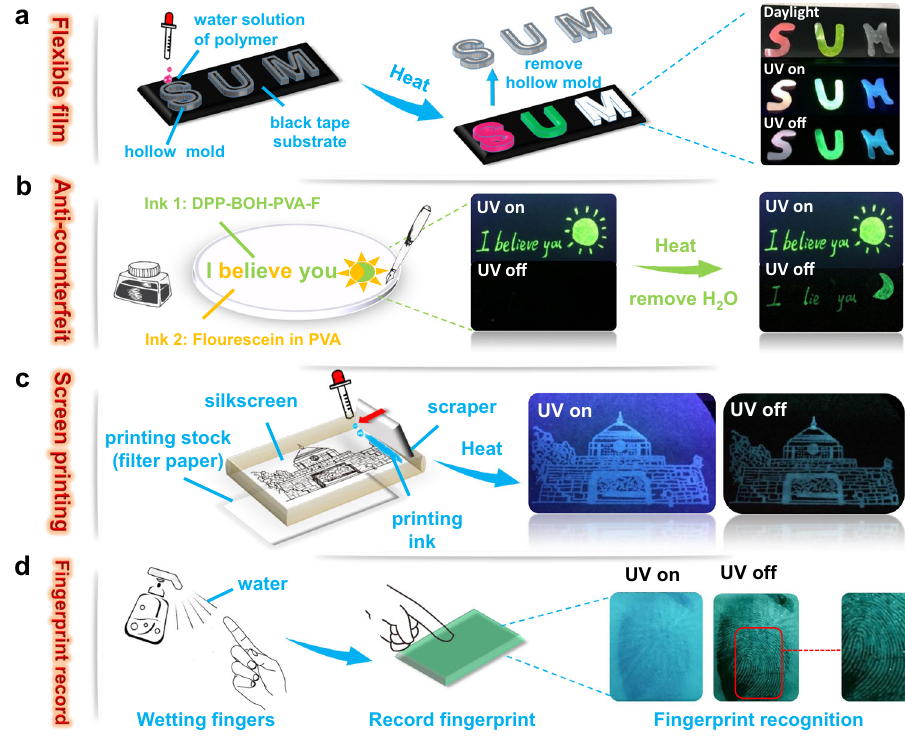
Fig. 5 Applications of stimulus-responsive afterglow materials. The schematic illustration of the application process for a fl exible fi lm, b anti-counterfeit, c screen printing, and d fi ngerprint